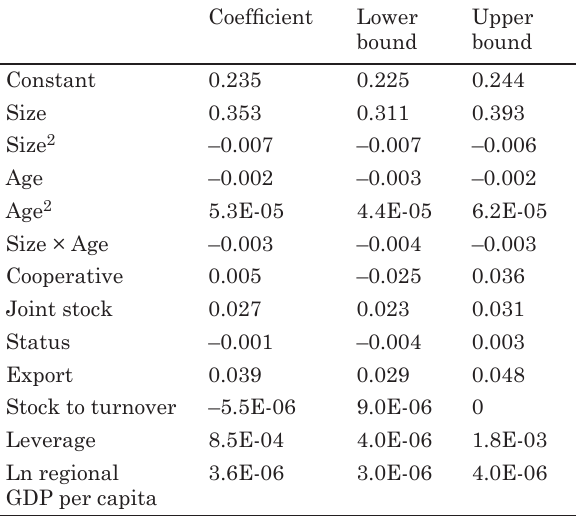
Table 5. Results of bootstrap truncated regression